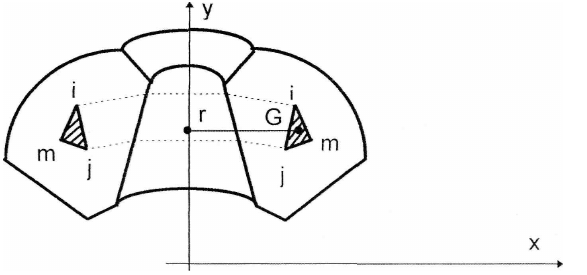
Figure 4. Symmetric body and toroidal finite element with triangular section, where r is the radius to the center of gravity G .